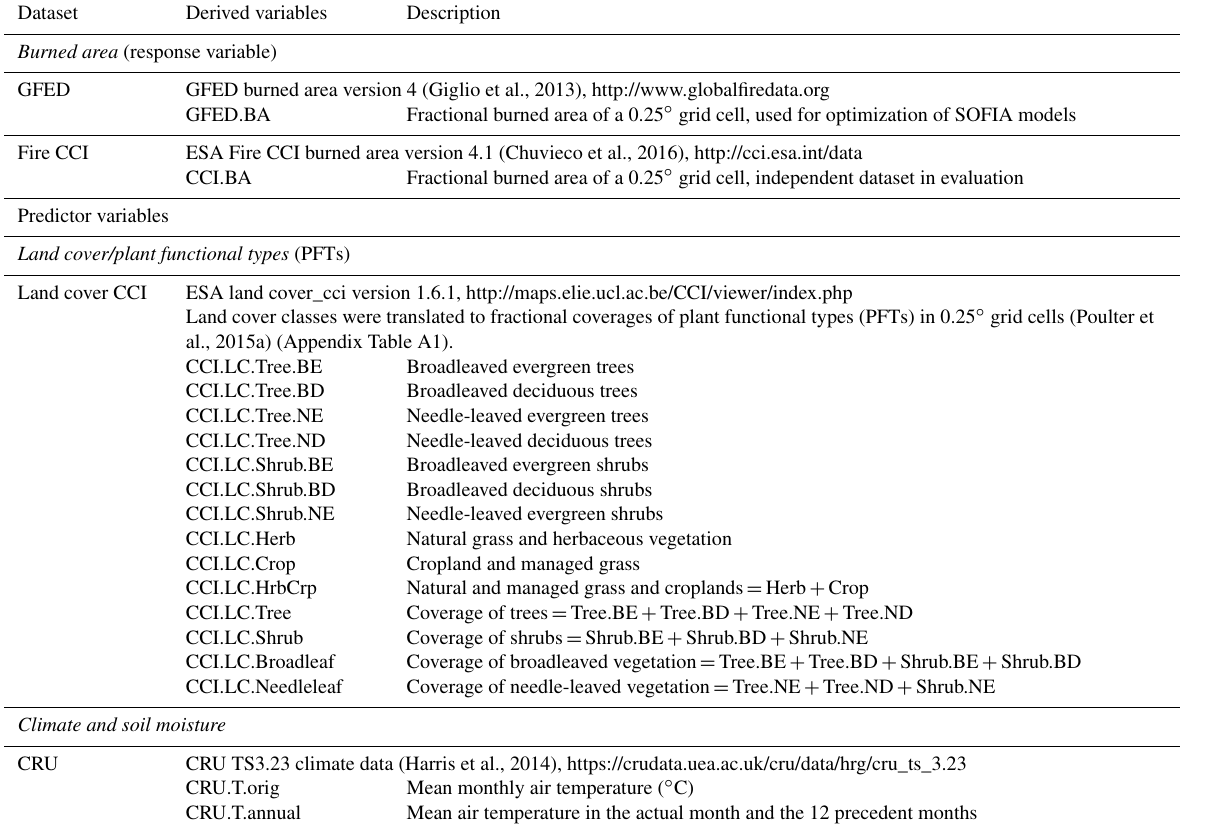
Table 1. Description of used datasets and derived predictor variables.